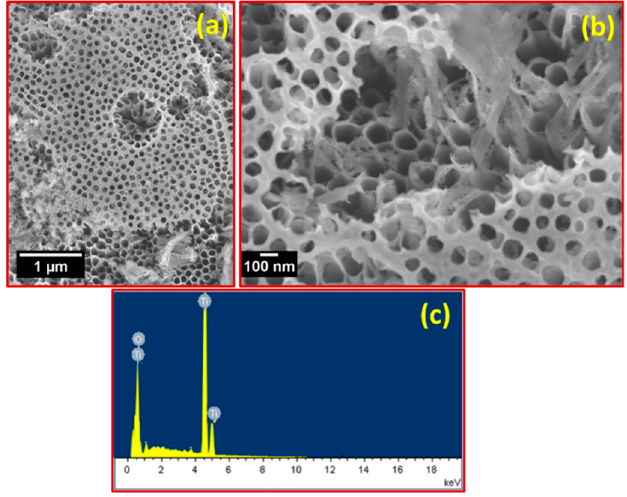
Figure 2. ( a ) Low and ( b ) high magnification field emission scanning electron microscopy (FE-SEM) images of TiO 2 nanotube arrays. ( c ) Corresponding energy-dispersive X-ray spectroscopy (EDX) spectrum.